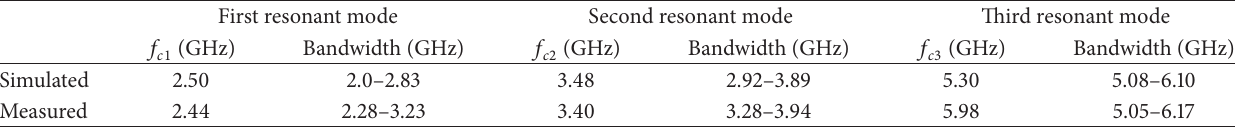
Table 1: Simulated and measured impedance bandwidths of the proposed antenna.